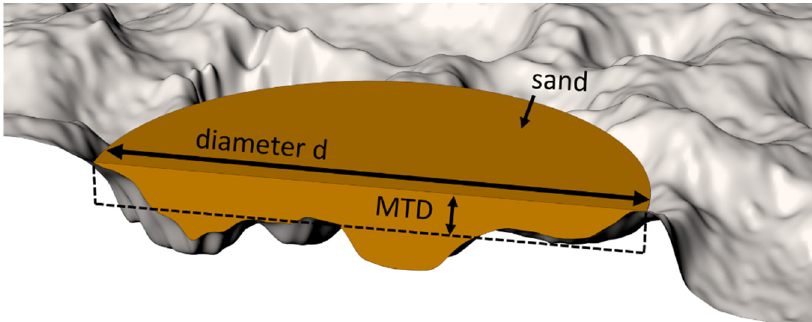
Figure 3. Illustration of the mean texture depth ( (cid:1839)(cid:1846)(cid:1830)